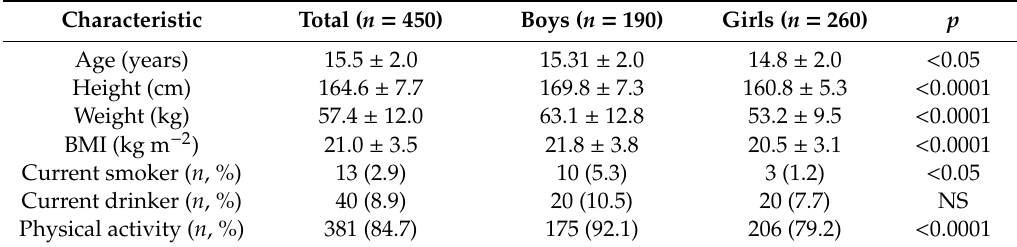
Table 1. General characteristics of Korean